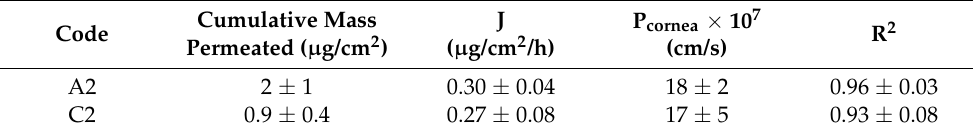
Table 4. Cumulative mass of bromfenac sodium permeated, steady-state flux J and permeability coefficient P cornea obtained by ex vivo test with drug-loaded A2 and C2 hydrogel discs. Hydrogel codes as in Table